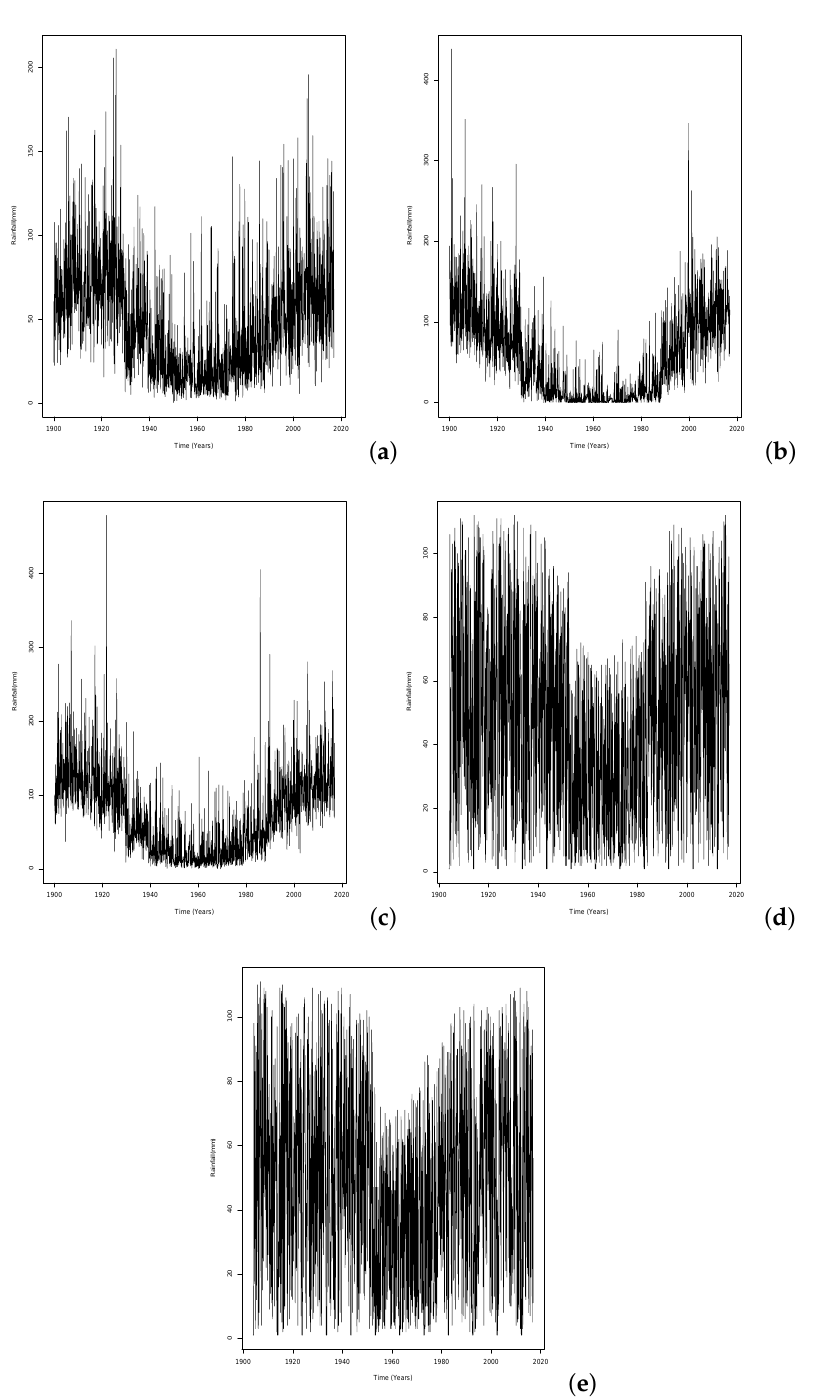
Figure 1. Time series plot for monthly rainfall in ( a ) Eastern Cape 1900–2017, ( b ) Gauteng 1900–2017, ( c ) KwaZulu-Natal 1900–2017, ( d ) Limpopo 1904–2017 and ( e ) Mpumalanga